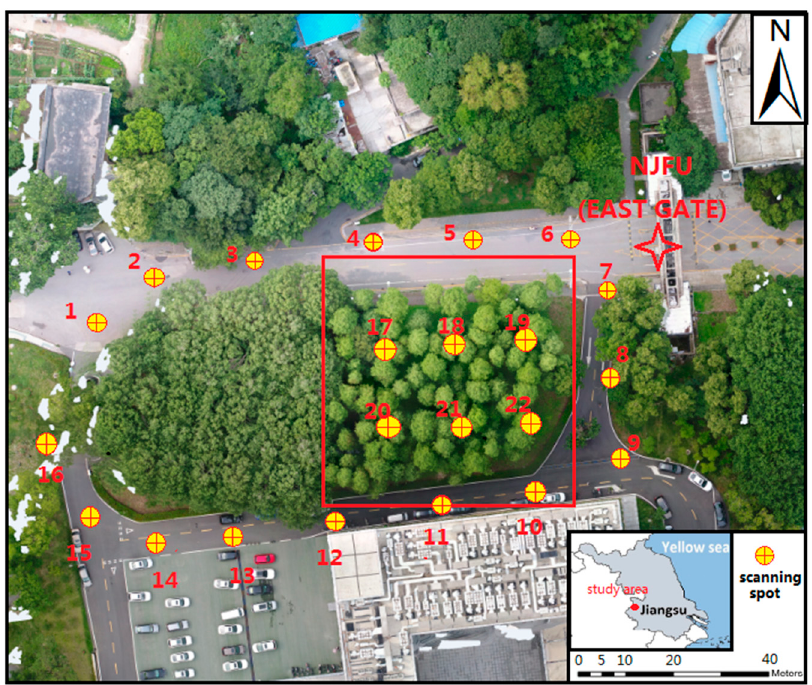
Figure 2. The study area and locations of scanning plots; the location of the sample spot is shown in the lower-right subfigure.